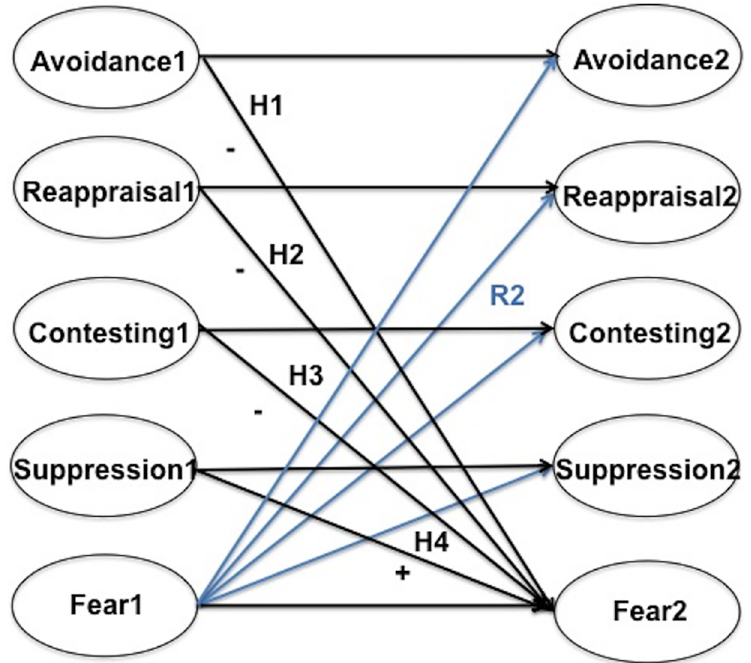
Fig 2. The initial model. Not shown are the correlations among the exogenous variables and the correlated item residuals across